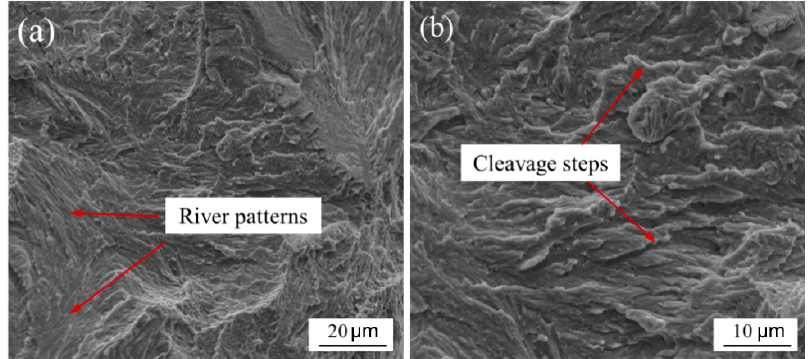
Figure 12. Fracture morphology. River patterns ( a ); Cleavege steps ( b ).